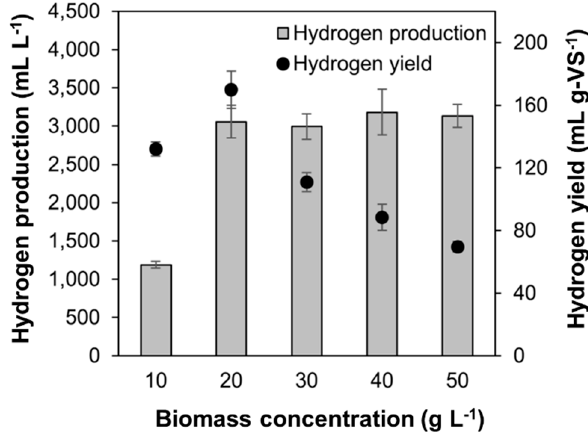
Figure 1. Hydrogen production from the biomass of Chlorella sp. at 10–50 g L − 1 via SSF.